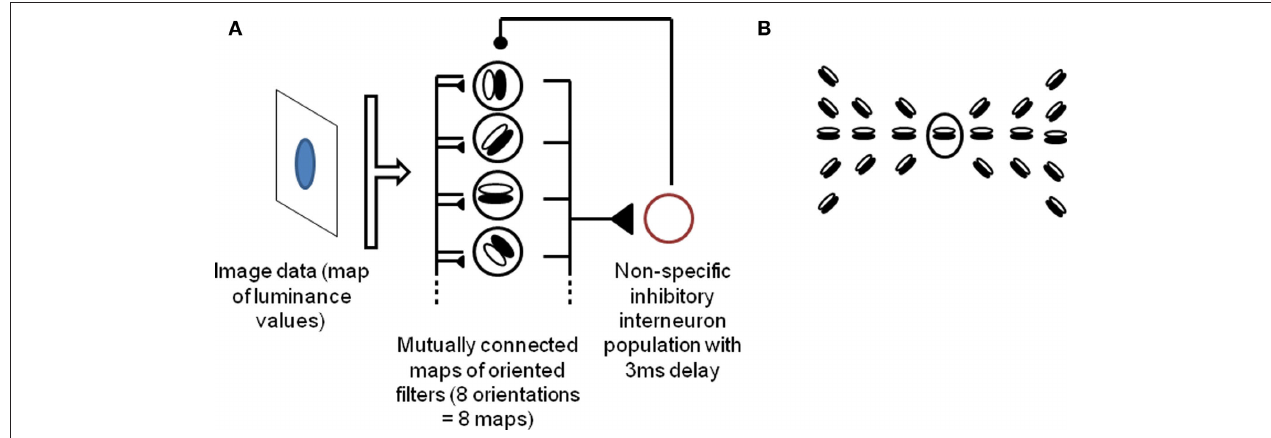
Figure 1 | Description of the model. (A) Outline of the model. A population of orientation-sensitive pyramidal neurons (modeled as oriented edge detectors) receives input from a map of luminance values, and sends output to a local interneuron population (modeled as a single inhibitory source). The inhibitory source discharges and sends an inhibitory potential to the pyramidal neurons, 3 ms after the first spikes, which temporarily inhibits the neurons. The iteration of this cycle leads to gamma-band oscillations and competitive firing among the pyramidal neurons (6). In addition, pyramidal cells send lateral excitatory connections to each